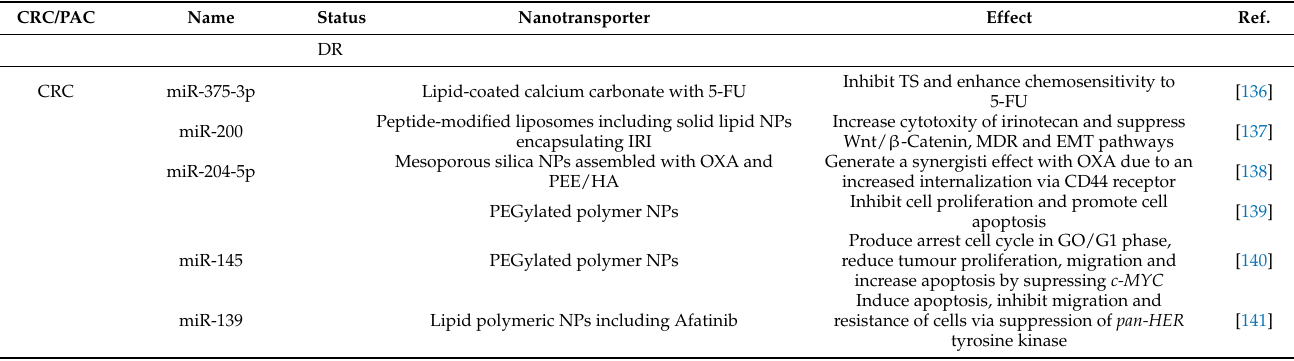
Table 2. Nanoformulations including mi-RNA to overcome resistance in colorectal and pancreatic cancers.